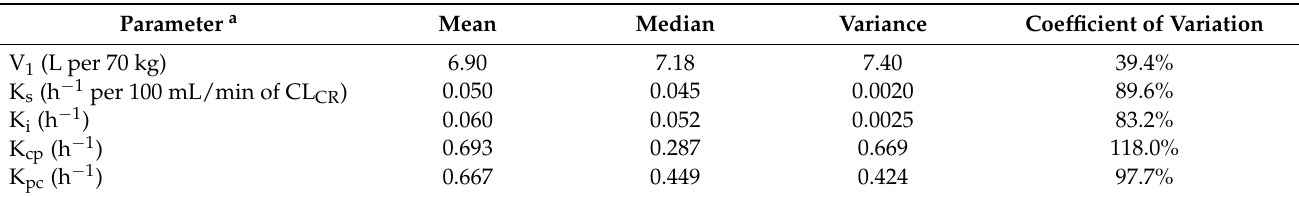
Table 2. Population parameter values of daptomycin in the learning dataset (Pmetrics